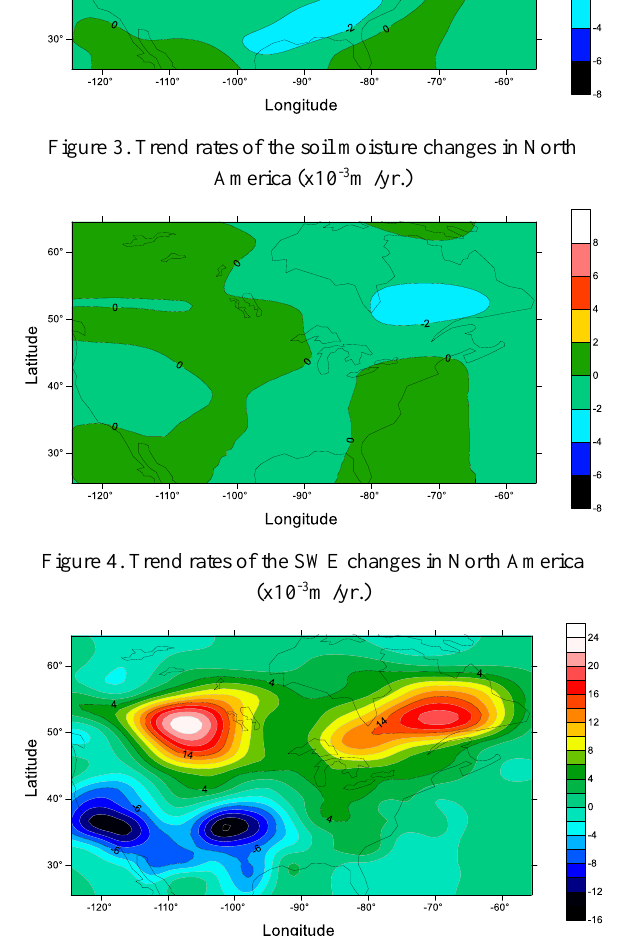
Figure 5. Trend rates of the separated GWS changes in North America (x10 -3 m /yr.)